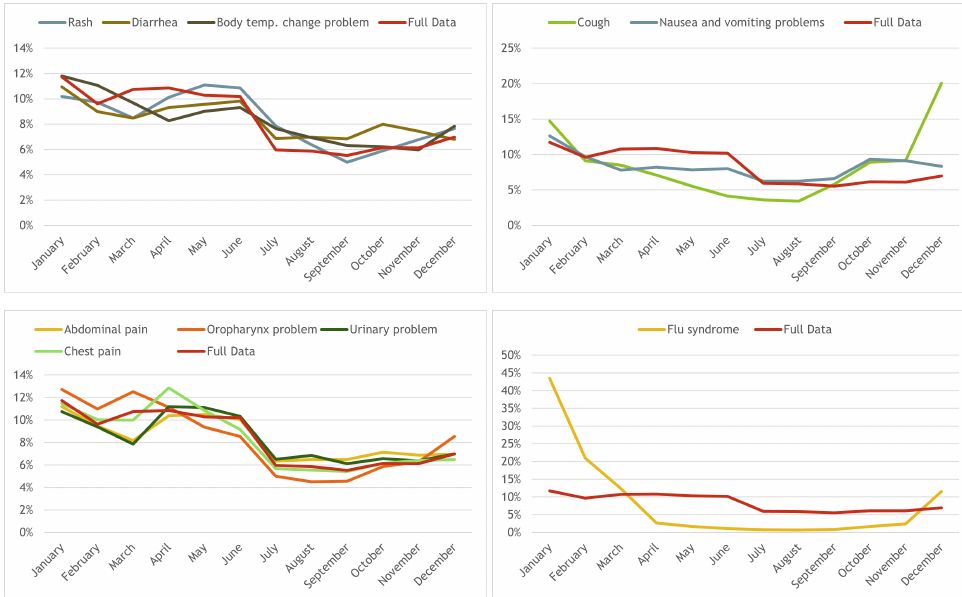
Figure 7. Distribution of calls per age for the 10 most frequent pathways (clustered by similarity over